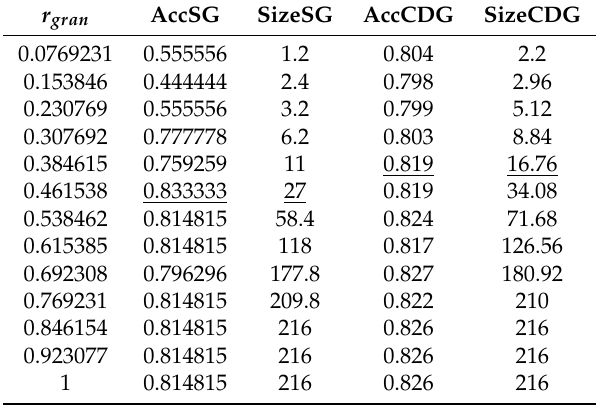
Table 13. Exemplary result for Standard vs. Concept-Dependent Granulation—5 times Cross Validation 5; Heart Disease data set; r gran = Granulation radius, AccSG = Accuracy of classification for Standard Granulation, AccCDG—Accuracy for Concept-Dependent Granulation, SizeSG = Granular decision system size for Standard Granulation, SizeCDG = Granular decision system size for Concept-Dependent Granulation. r gran AccSG SizeSG